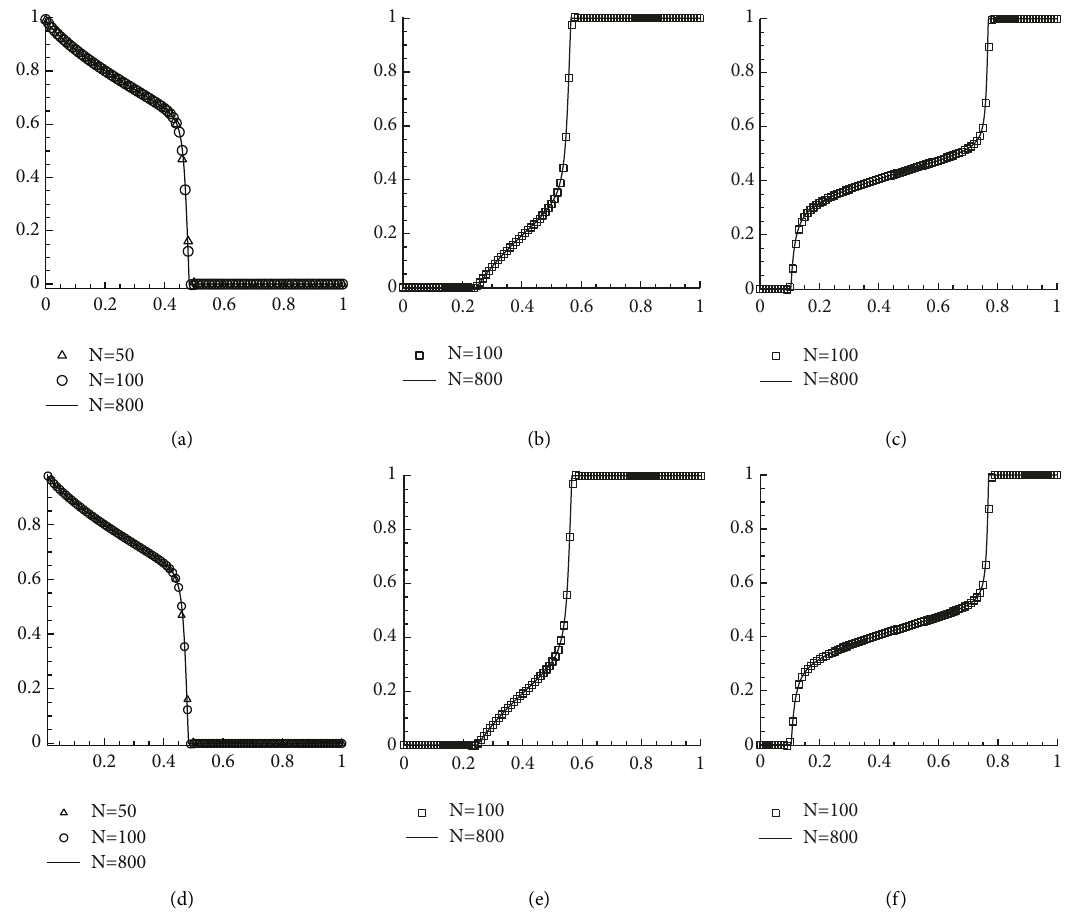
Figure 4: Example 5. (a) shows the initial boundary value problem without gravity for CRUS-WENO scheme. (b) and (c) show the results of the Riemann problem without gravity and with gravity for CRUS-WENO scheme, respectively. (d) shows the initial boundary value problem without gravity for WENO-JS scheme. (e) and (f) show the results of the Riemann problem without gravity and with gravity for WENO-JS scheme, respectively.